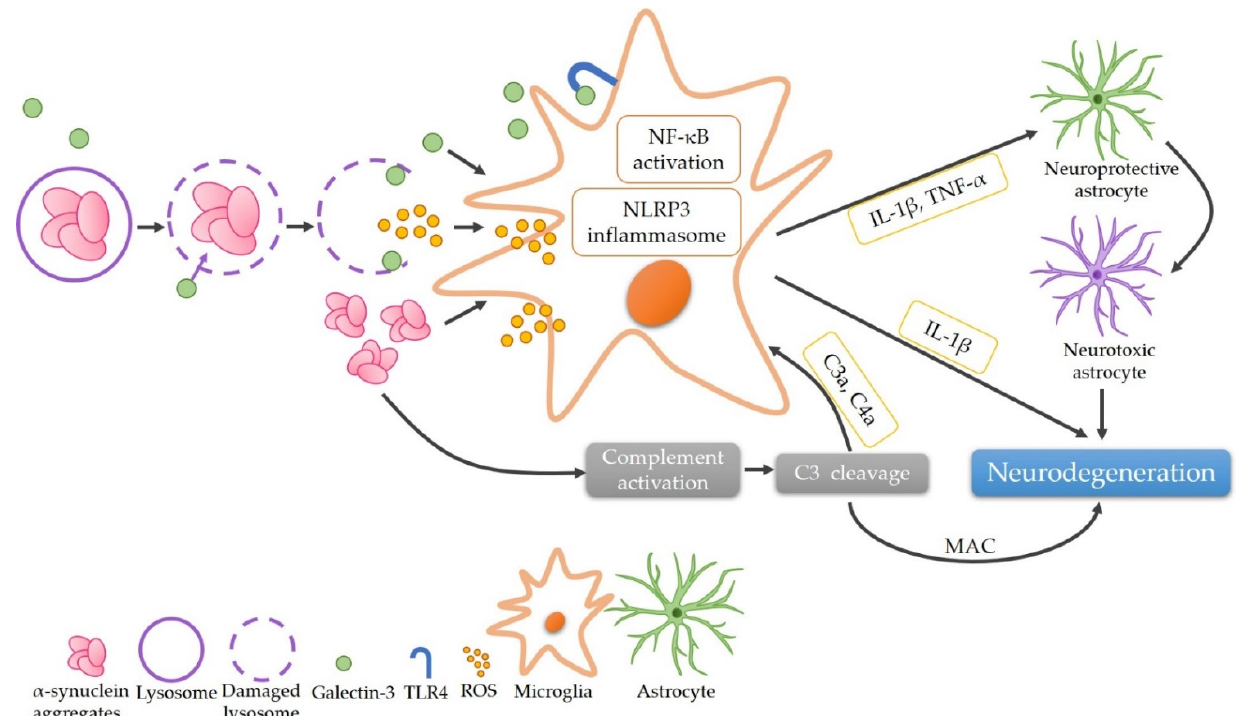
Figure 3. The proposed role of α -synuclein aggregates in the pathogenesis of Parkinson’s disease via the complement- phagocytic pathway. The phagocytosis of α -synuclein leads to the rupture of lysosomes and recruitment of galectin-3, releasing α -synuclein aggregates and ROS that activate microglia subsequently. Galectin-3 further activates microglia via promoting either NF- κ B pathway by directly binding TLR4 or the assembly of NLRP3 inflammasomes, resulting in the secretion of IL-1 β and TNF- α . These pro-inflammatory cytokines cause neurodegeneration directly or through converting neuroprotective astrocytes to neurotoxic ones. α -Synuclein aggregates also activate the complement system, thereby activating microglia or leading to neurodegeneration through the formation of MAC. (C3: complement component 3; C3a: complement component 3a; C4a: complement component 4a; IL-1 β : interleukin 1-beta; MAC: membrane attack complex; NF- κ B: nuclear factor kappa-light-chain-enhancer of activated B cells; NLRP3: the NLR family pyrin domain containing 3; ROS: reactive oxygen species; TLR4: Toll-like receptor 4; TNF- α : tumor necrosis factor-alpha).